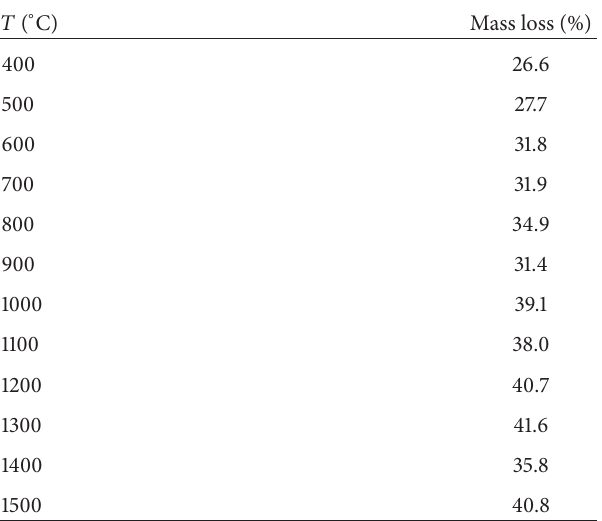
Table 1: Mass loss of hydrocalumite samples calcined at different